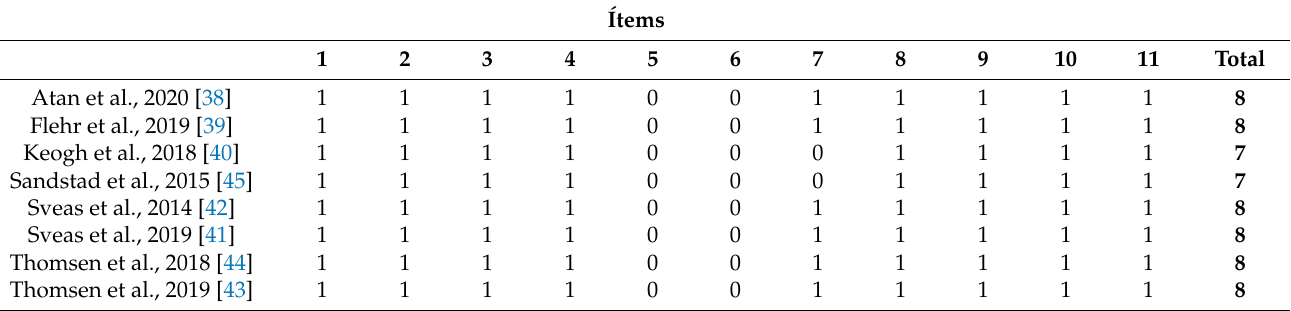
Table A3. Assessment of the studies quality based on PEDro Scale.